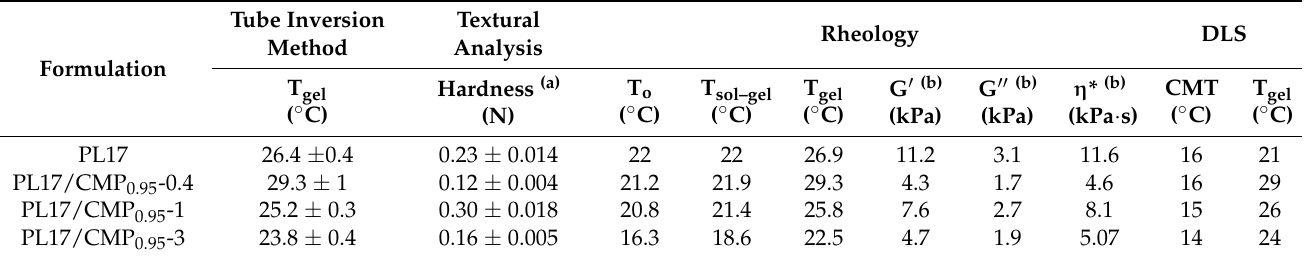
Figure 6. Sol–gel transition illustrated for sample PL17/CMP 0.95 -0.4 through the dependence of the viscoelastic parameters on temperature ( a ); variation of loss modulus during temperature induced gelation for PL17/CMP 0.95 samples ( b ) (heating rate of 0.5 °C/min, ω = 1 rad/s, γ = 1%). Table 2. Thermogelation parameters for PL17 and PL17/CMP 0.95 mixtures determined from different measurements.